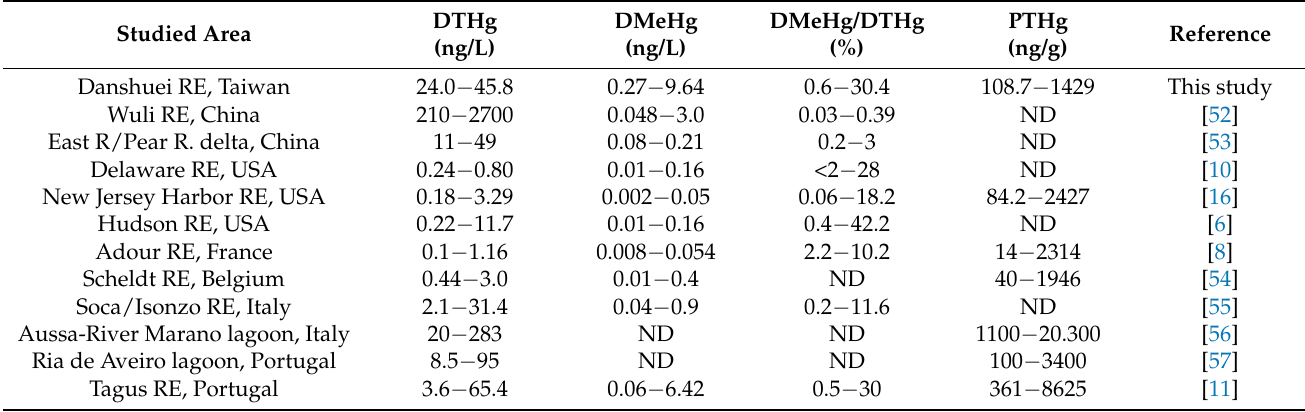
Table 2. Comparison the concentration ranges of dissolved total Hg (DTHg), dissolved methyl Hg (DMeHg), and particulate total Hg (PTHg) obtained in the Danshuei River Estuary with values reported for other eutrophic estuaries around the world. Studied Area